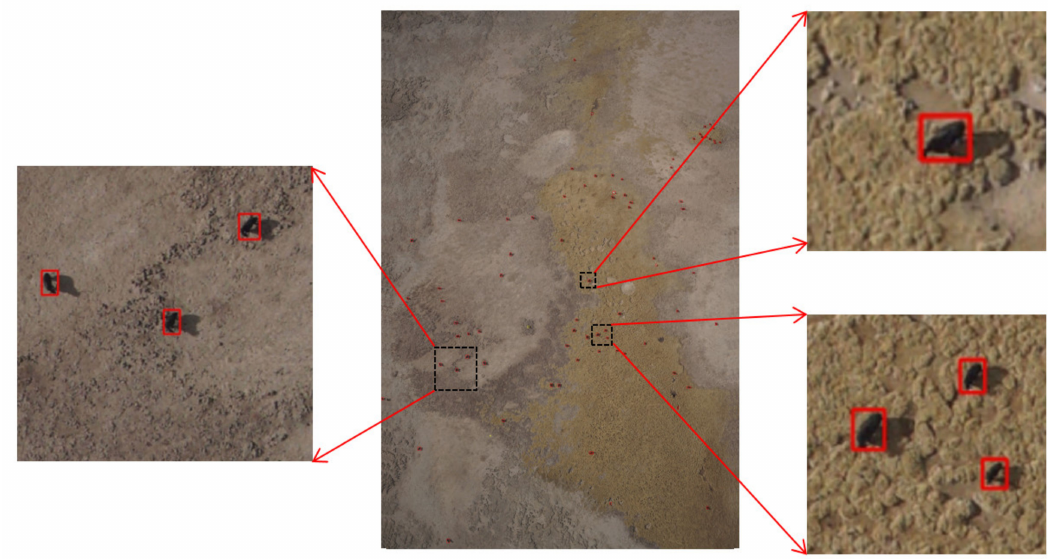
Figure 17. Result diagram of detection performed using new overlapping segmentation (the red boxes in the figure are the detection result boxes detected by the improved Faster-RCNN model using the new overlapping segmentation method proposed in this